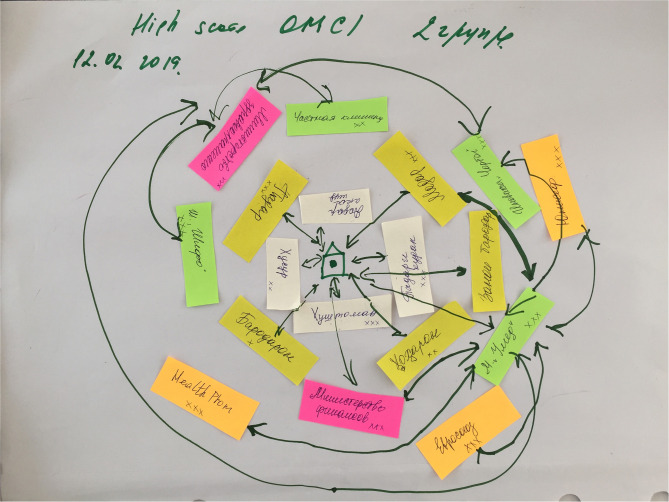
An example net-map.